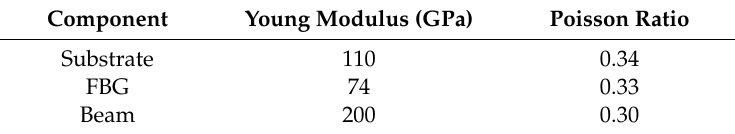
Figure 6. Simulation diagram of sensor. ( a ) Horizontal deformation, ( b ) Vertical deformation.